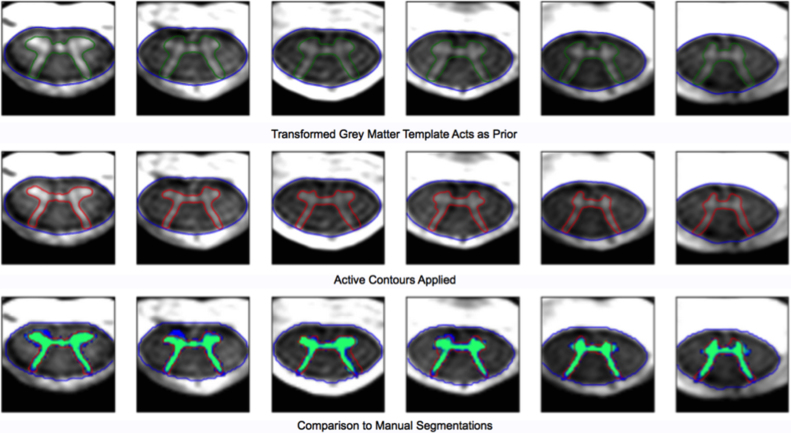
Example of MGAC with comparisons to manual segmentations.